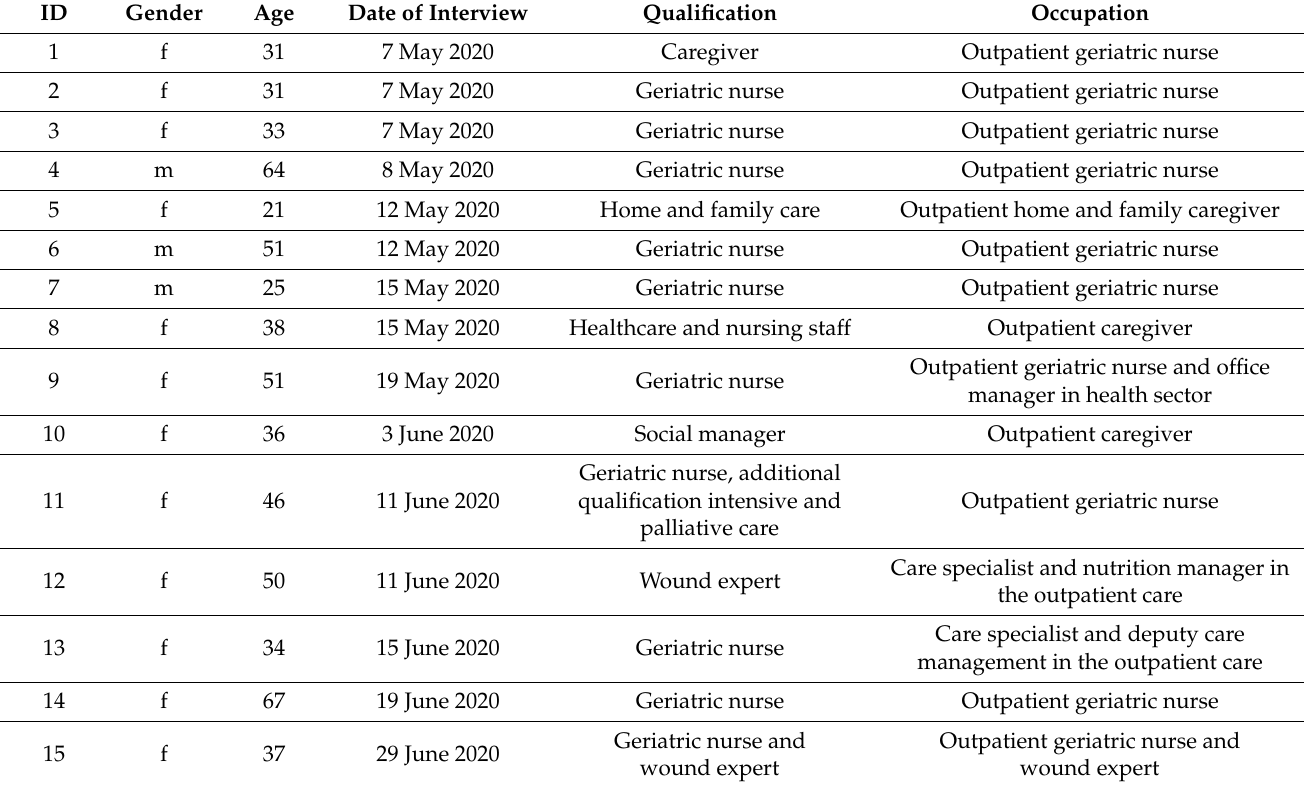
Table 2. Participant characteristics ( n =